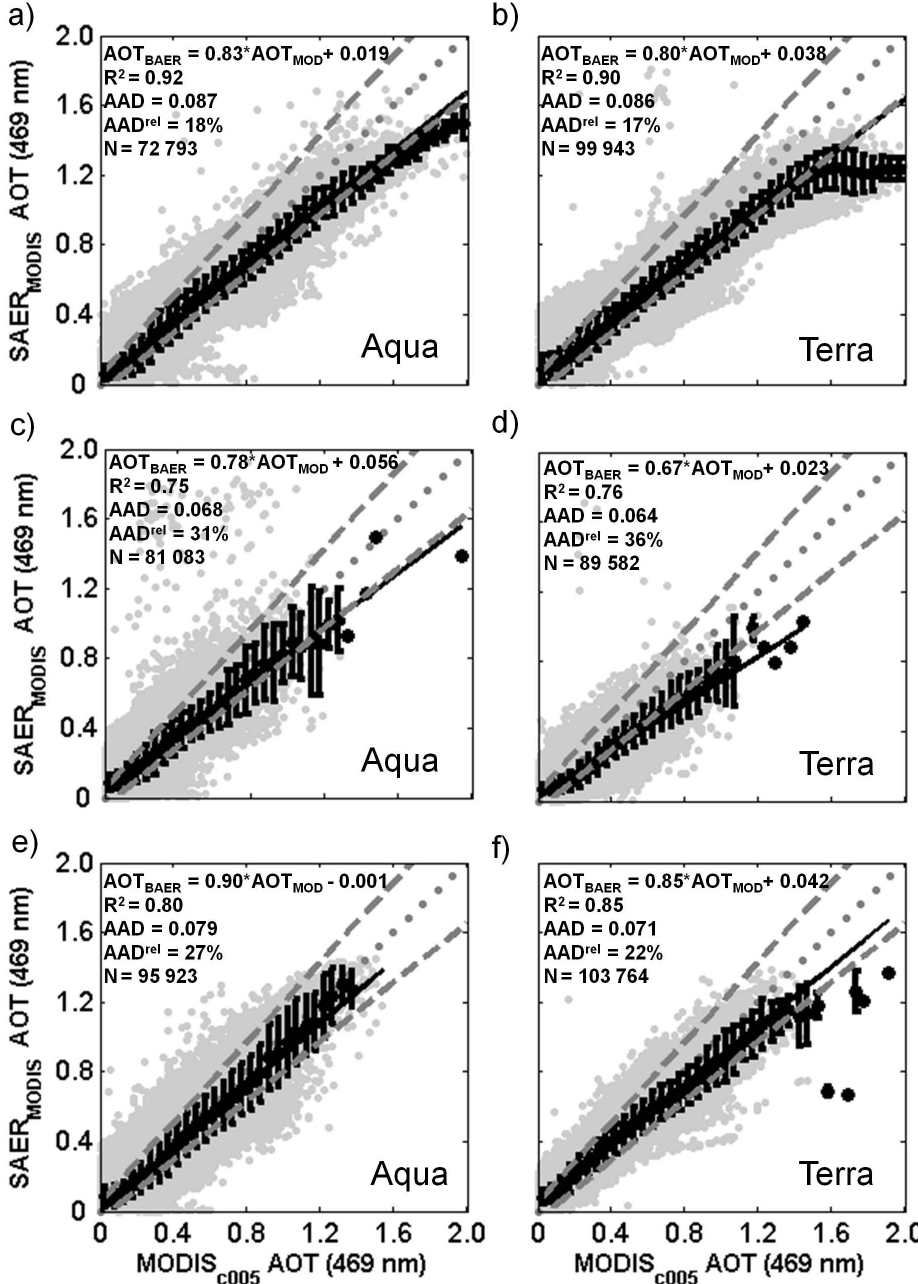
Fig. 9. Pixel-by-pixel (10km) comparison of SAER and MODIS c005 AOT over land surfaces in Europe according to Aqua (left column) and Terra (right column) and period 1 (top panels), 2 (middle panels) and 3 (bottom panels). Black dots and error bars denote mean AOT values in intervals of 0.05 and the corresponding one standard deviation, respectively. The solid black, dashed and dotted grey lines represent linear fits, expected uncertainties for one standard deviation of the MODIS c005 aerosol retrievals and 1-to-1 line, respectively. The regression equation given in each plot was calculated from the data before binning. The explanation of abbreviations is given in Sect.